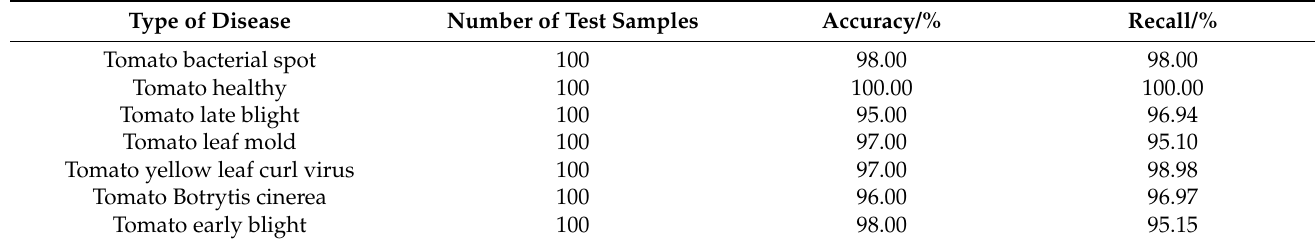
Table 2. The recognition rate of each type of disease image on the multi-modal.